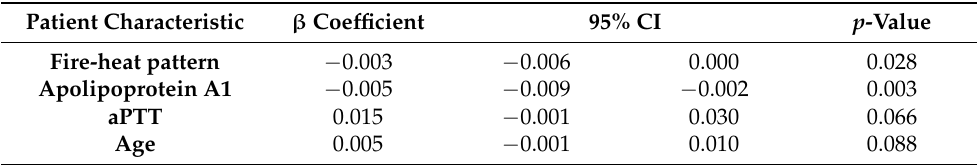
Table 7. Logistic regression results for predicting post-stroke